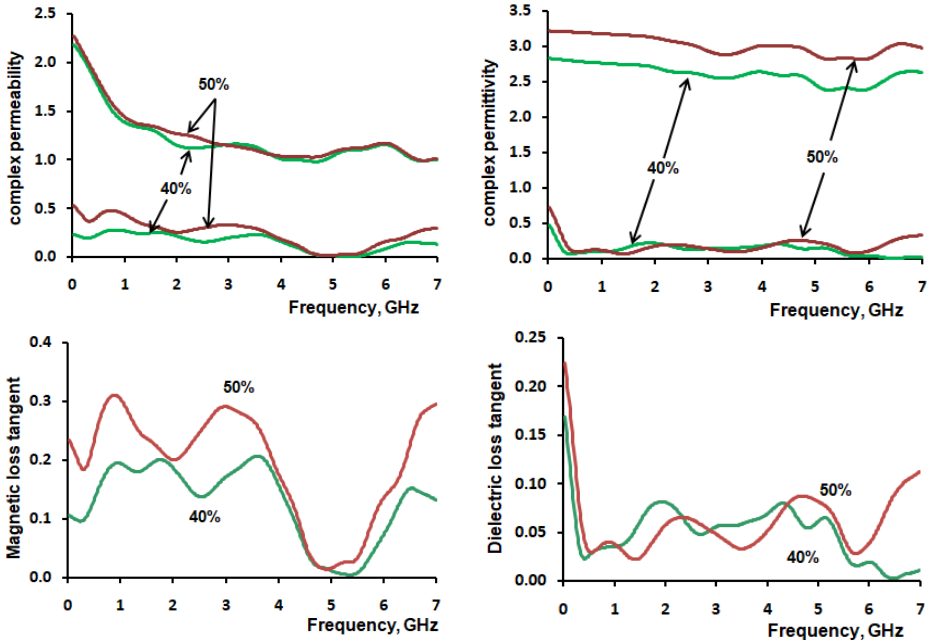
Figure 6. The complex permeability, complex permittivity, magnetic loss and dielectric loss tangent of MgFe 2 O 4 –paraffin composite.